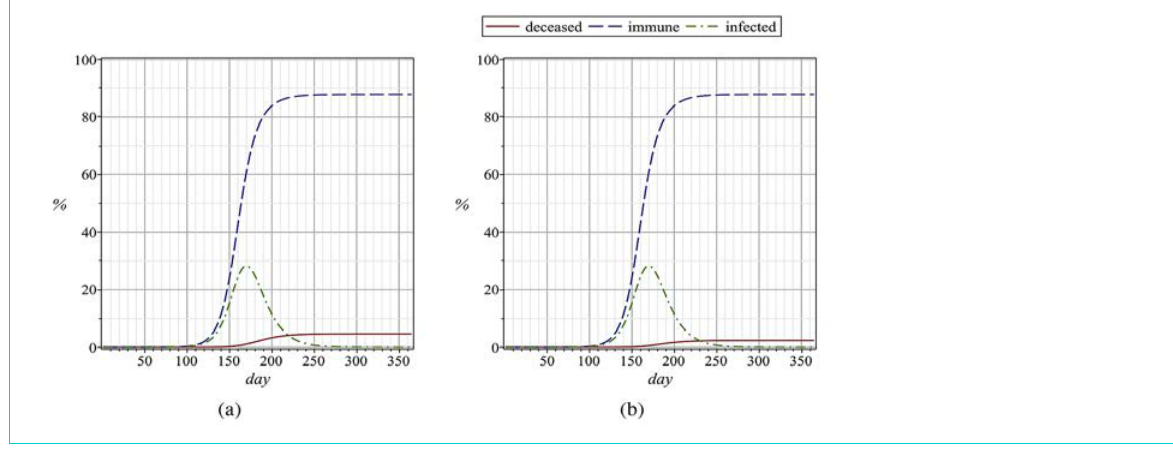
) for a period of 1 year; left with intensive care unit limitation and right ), dash-dotted lines the infected ( ℛ 0 = 2.4 𝑠𝑠0 𝑛𝑛 − 𝑛𝑛 𝑠𝑠